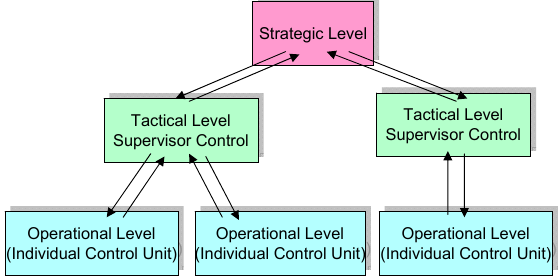
Figure 4. Illustration of a multi-level control approach to hybrid power systems.